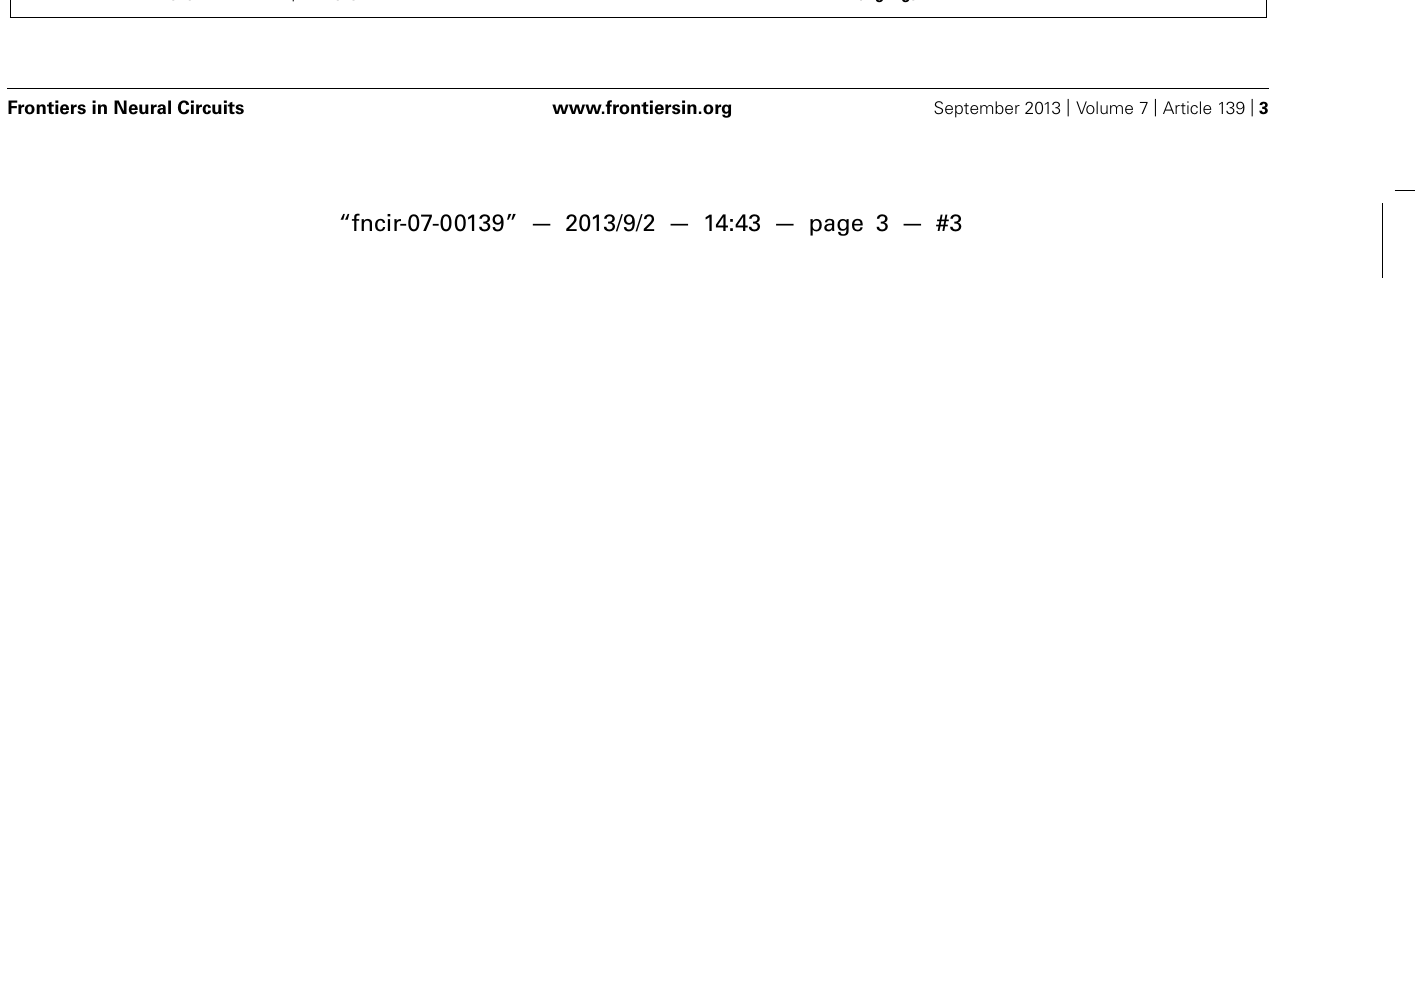
transients occurred only in the intermediate zone (A 1 ,B 1 ) that the ρ subunit containing GABA A receptor antagonist (1,2,5,6-tetrahydropyridin-4-yl)-met- hylphosphinic acid (TPMPA) was inefficient in the cortical plate (A 2 ,B 2 ) and that the GABA A antagonist bicuculline (BMI) completely abolished GABAergic Ca 2 + transients in the CP (A 3 ,B 3 ) . Modified from Denter etal.